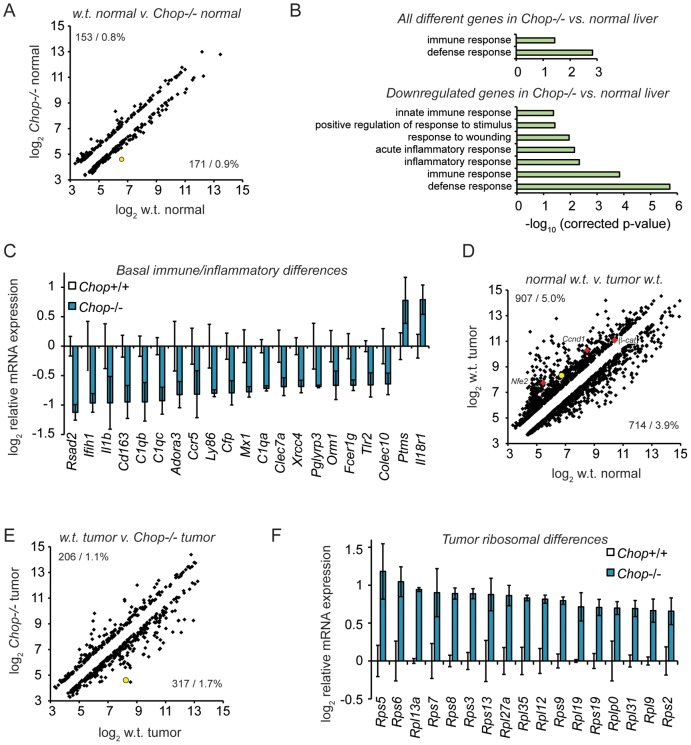
Microarray profiling reveals CHOP-dependent differences in inflammation and ribosomal biogenesis genes.(A) Basal expression differences in Chop−/− mice. 18,138 significantly expressed genes were analyzed using Illumina MouseRef-8 v2.0 BeadChips, with total RNA from 9 month old mouse liver homogenate as input. The number and percentage of genes upregulated (upper left) and downregulated (lower right) in wild-type versus Chop−/− tissue is shown, showing only genes differing by 1.5-fold or more, p<0.05. Expression is given on a log2 scale. In (A), (D), and (E), the position of Chop is shown as a yellow-filled circle. (B–C) Suppressed basal expression of genes involved in immune and inflammatory pathways in Chop−/− mice. (B, top) GO pathways enriched among all regulated genes in PBS-treated wild-type versus Chop−/− animals were determined using DAVID, with all pathways that were significantly enriched after Bonferroni correction shown. (B, bottom) Same as (top), but considering only genes downregulated in Chop−/− animals. (C) Average array-determined expression of genotype-dependent immune- and inflammation-related genes from PBS-treated animals is shown on a log2 scale +/− S.D.M. All genes shown are differentially expressed >1.5-fold (i.e., >0.585 on the y-axis), p<0.05. (D) DEN treatment alters gene expression in wild-type mice. Scatter plot of all genes differentially expressed (>1.5-fold; p<0.05) in tumors from 9 month-old DEN-treated wild-type animals versus normal liver tissue in age-matched PBS-treated wild-type animals. The positions of Nfe2, Cyclin D1 (Ccnd1), and β-catenin are indicated by red diamonds. (E–F) Uniform upregulation of genes involved in ribosome biogenesis in tumors from Chop−/− mice. (E) Scatter plot of gene expression from tumor tissue of DEN-treated wild-type animals compared to Chop−/− animals is presented, showing all genes differing by >1.5-fold, p<0.05. (F) Average expression of all ribosomal subunit genes that were significantly different (p<0.05, fold-change >1.5) in Chop−/− versus wild-type large tumors is shown on a log2 scale +/− S.D.M. as in (C).